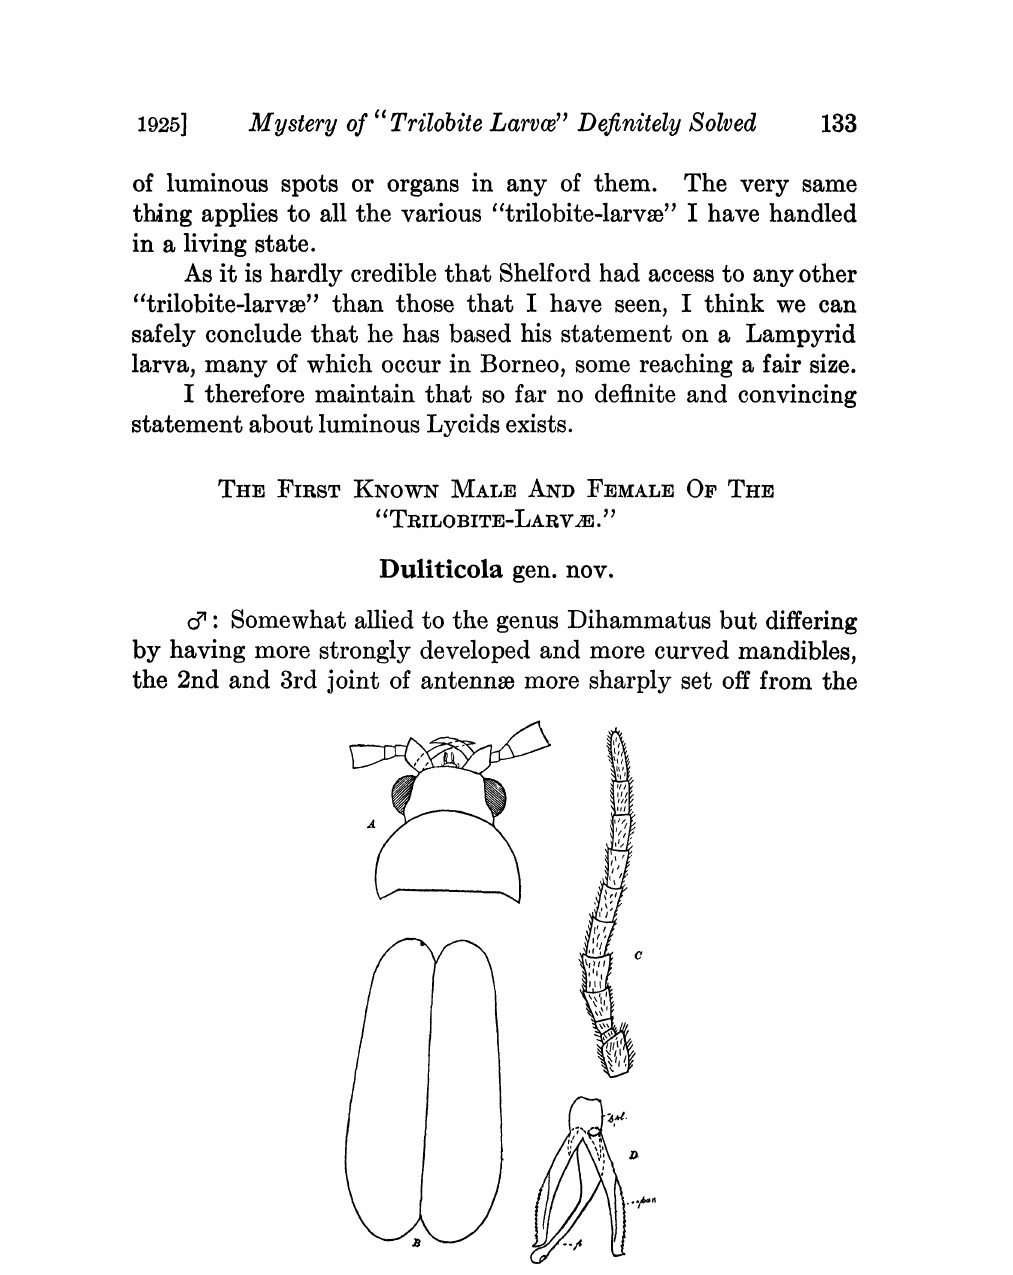
Fig. 1. Male of Duliticola #aradoxa op, nov. A, head and prothorax from above; B, outline of elytra; C, antenna; D,